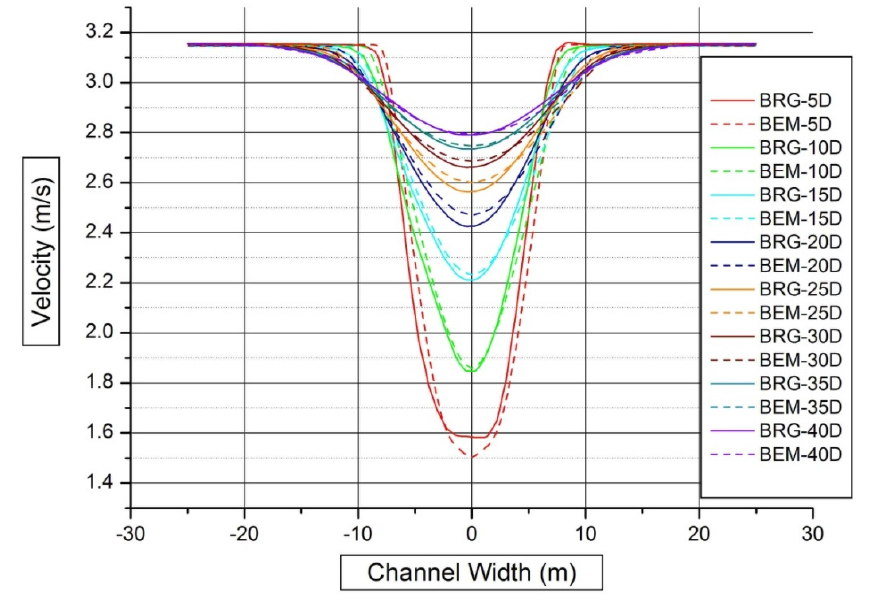
Figure 3. Comparison of the velocity deficit in the rotor wake from BEM-CFD and blade-resolved geometry (BRG) models at a range of downstream